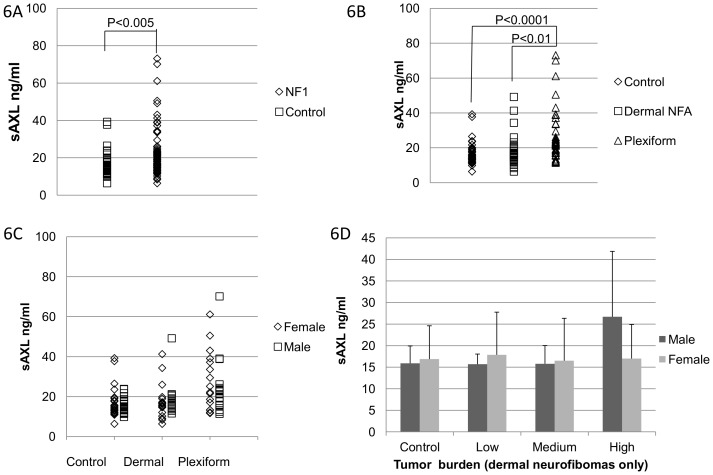
Increased plasma levels of sAXL in patients with plexiform neurofibromas.
A, patients with neurofibromatosis had significantly higher plasma levels of sAXL. There were 72 NF1 patients (diamonds) and 46 controls (squares). The sAXL level was significantly higher in NF1 patients than that of controls (p-value <0.005). B, patients without plexiform tumors (group ‘Dermal NFA’, squares) had the same levels of sAXL compared to the healthy controls (group control, diamonds, n.s.  =  non-significant), while the levels were markedly increased in the patients with plexiform tumors (group ‘Plexiform’, triangles) compared to both the dermal NFA group (p<0.01) and the healthy control group (p<0.0001). C, there was not any significant difference between the male (squares) and female (diamonds) participants in any of the groups. D, within the dermal NFA group, males with a high number of dermal neurofibromas (>100) had significantly higher sAXL levels than that with a low NFA tumor burden (<30) (p<0.05). Nevertheless, no significant difference was found among female groups.